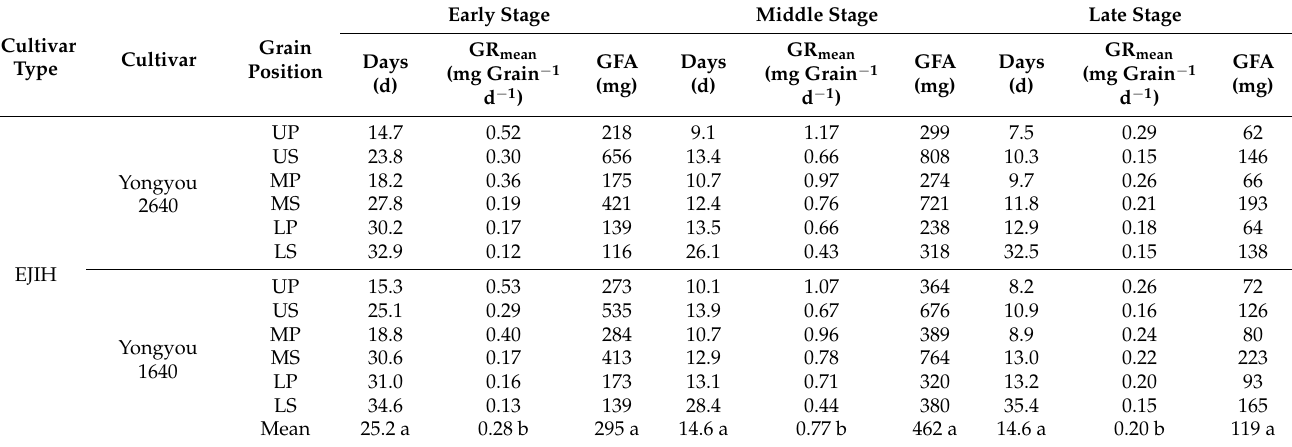
Table 10. Grain-filling characteristics during early, middle, and late stages of rice